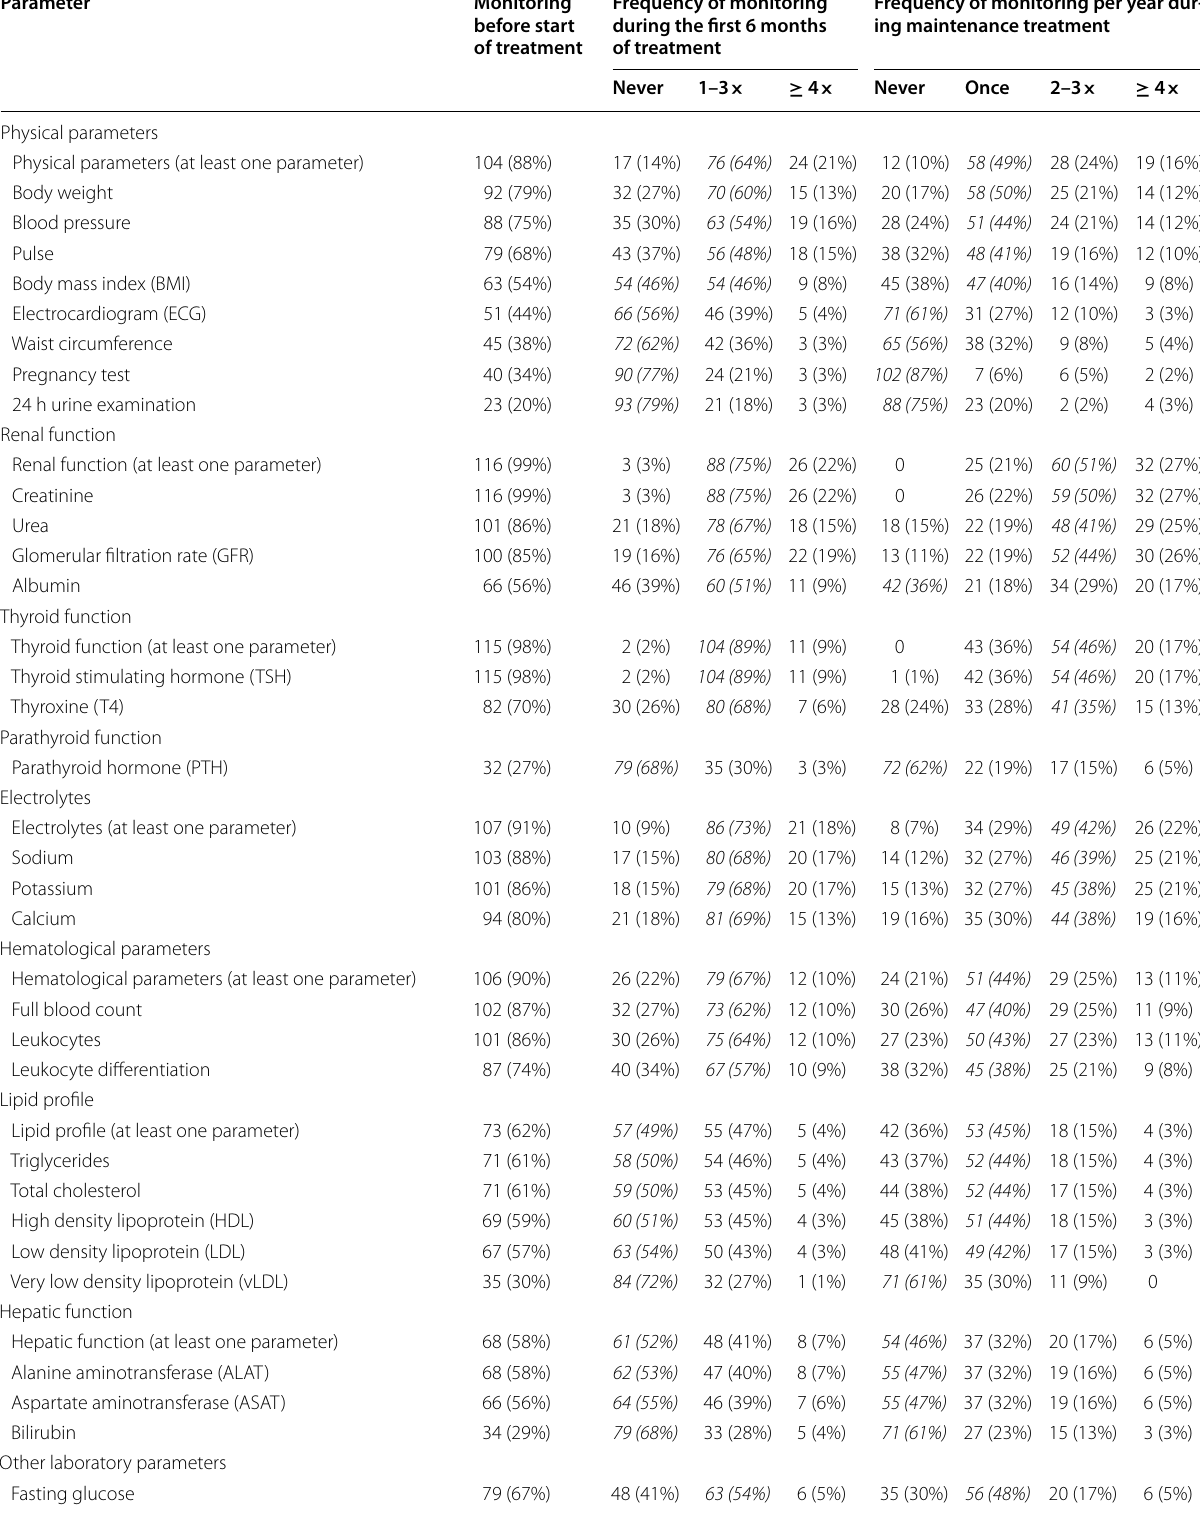
Table 3 Monitoring of physical and laboratory